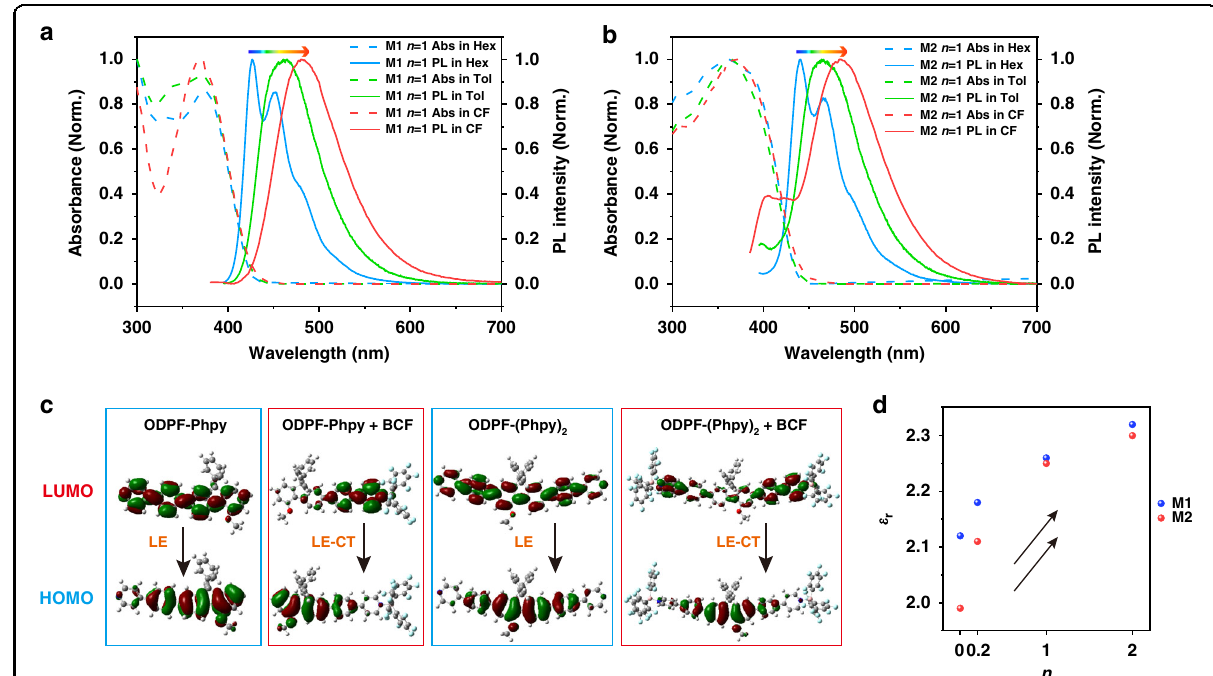
Fig. 3 The ICT feature of coordinated compounds. a Abs and PL spectra of M1 in Hex, Tol and CF. Concentration: 10 − 5 mol L − 1 . b Abs and PL spectra of M2 in Hex, Tol and CF. Concentration: 10 − 5 mol L – 1 . c The electron density distribution of HOMO and LUMO of original compounds and coordinated compounds. d The dielectric constant of blending fi lms with different